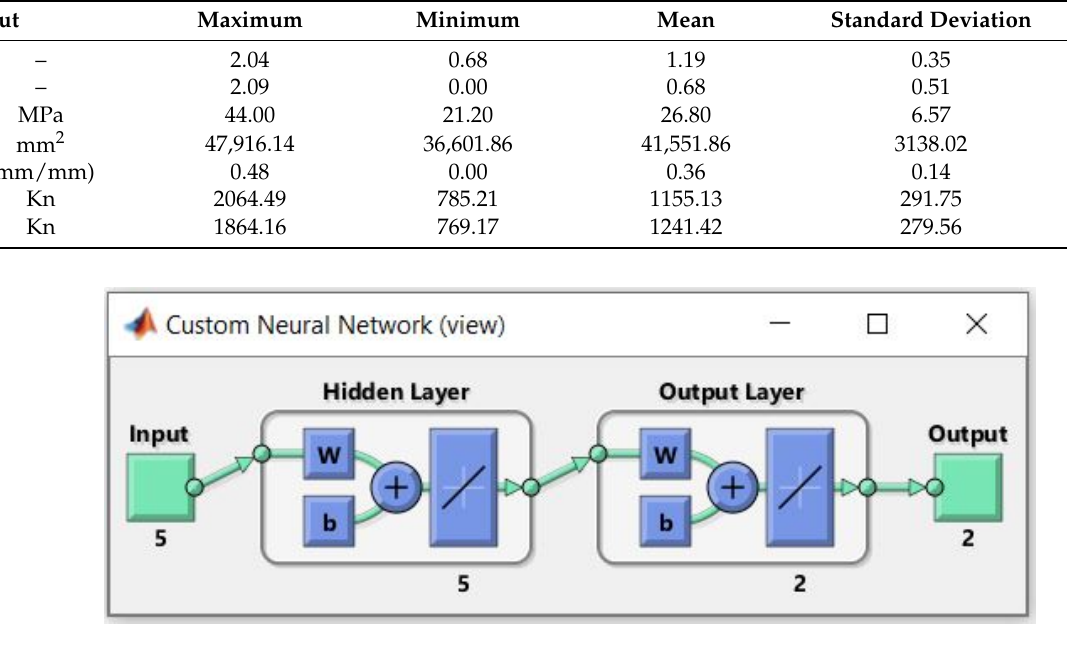
Figure 16. ANN architecture of the proposed first and second peak load capacities of HCCs.